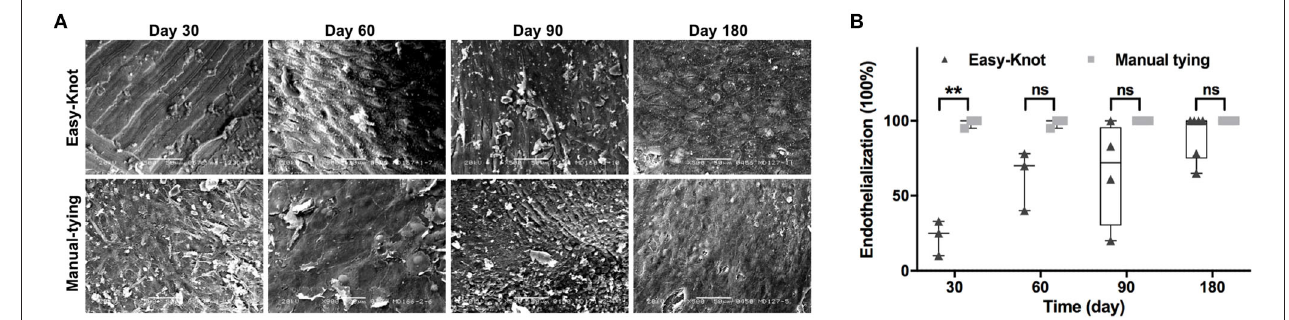
FIGURE 6 | The ultrastructure of knotting site surface under scanning electron microscope (SEM) and endothelialization. * p < 0.05; ** p < 0.01; ns, not significant. (A) The dynamic change of the ultrastructure of endothelial cell coating on the metal surface of titanium clip or the manual-tying knotting site under SEM at indicated time points. (B) Statistical analysis of the percentage of endothelialization in the Easy-Knot group and the manual-tying group. * p < 0.05; **, p < 0.01; ns, not significant.